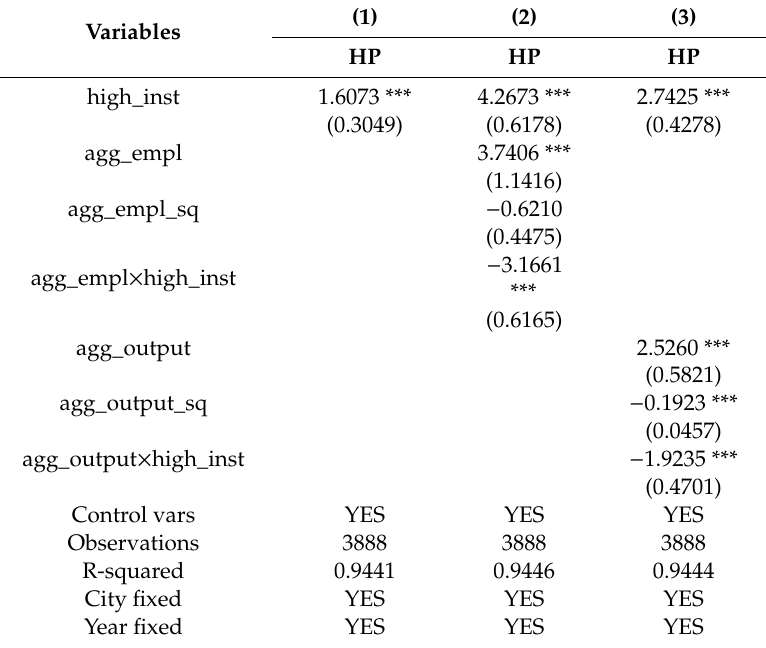
Table 7. Moderating e ff ect—institutional